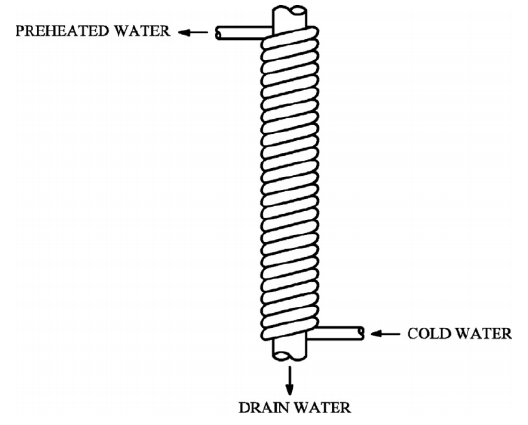
Figure 2. Basic working principle diagram of a vertical WWHR unit [13].